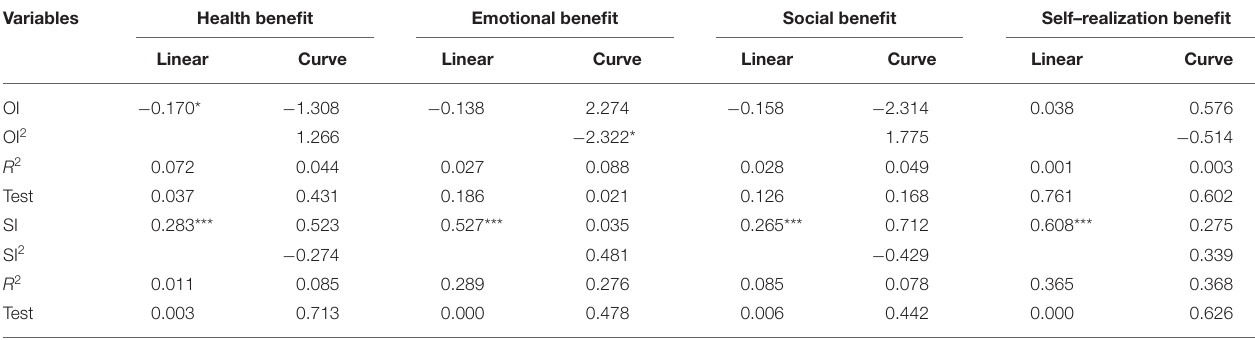
TABLE 5 | The impact of degrees of involvement on psychological and hedonic leisure.